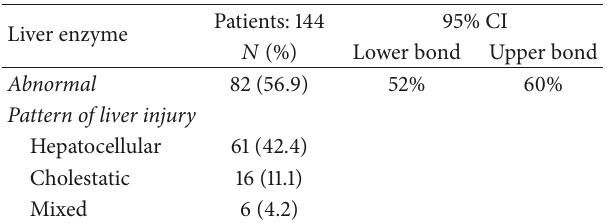
Table 2: Liver enzyme status. Patients: 144 95% CI Liver enzyme 𝑁 (%) Lower bond Upper bond Abnormal 82 (56.9) 52% 60% Pattern of liver injury Hepatocellular 61 (42.4) Cholestatic 16 (11.1) Mixed 6